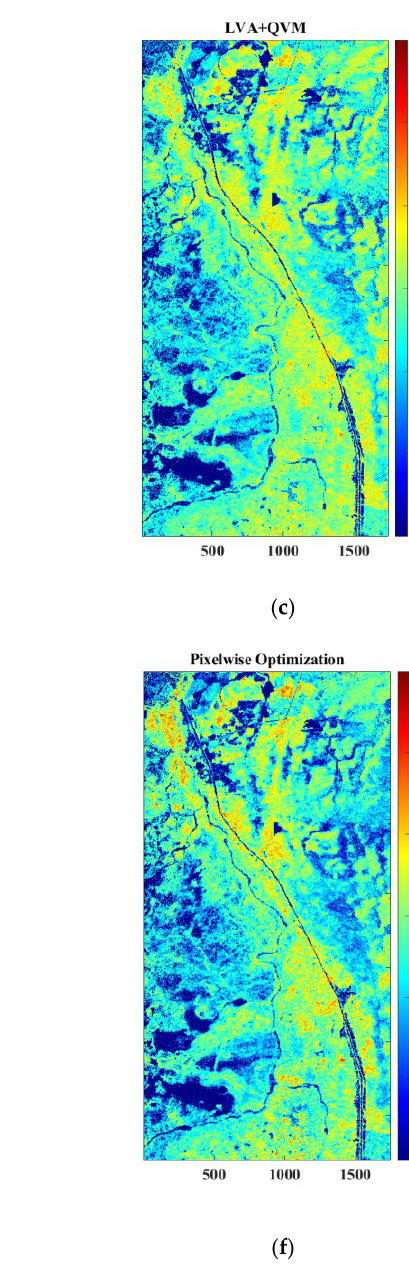
Figure 9. Forest height inversion results (in meters) over the BERMS site based on different models. ( a ) LVIS RH100 height; ( b ) LVA + LVM; ( c ) LVA + QVM; ( d ) QVA + LVM; ( e ) QVA + QVM; ( f ) Pixel-wise optimization.